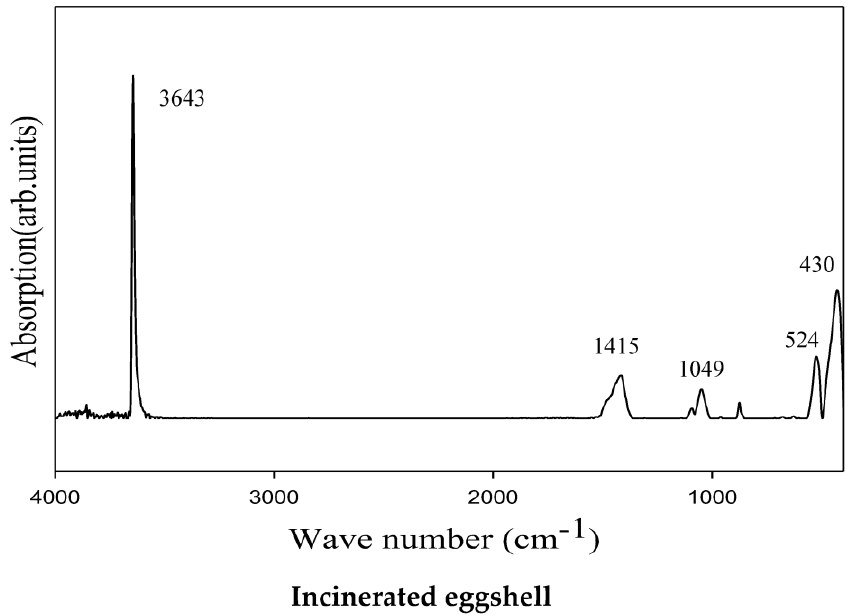
Figure 2. The Fourier transform infrared spectroscopy (FTIR) spectrum of original ( top ) and incinerated ( bottom ) eggshell.